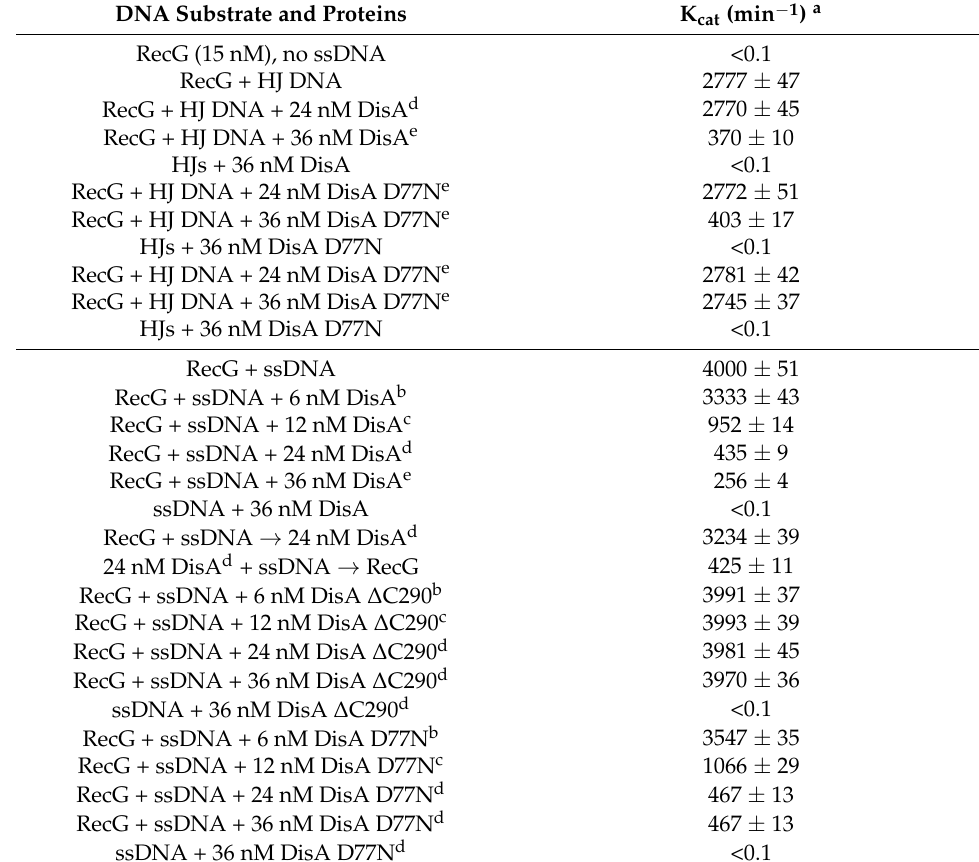
Table 1. RecG rates of DNA-dependent ATP